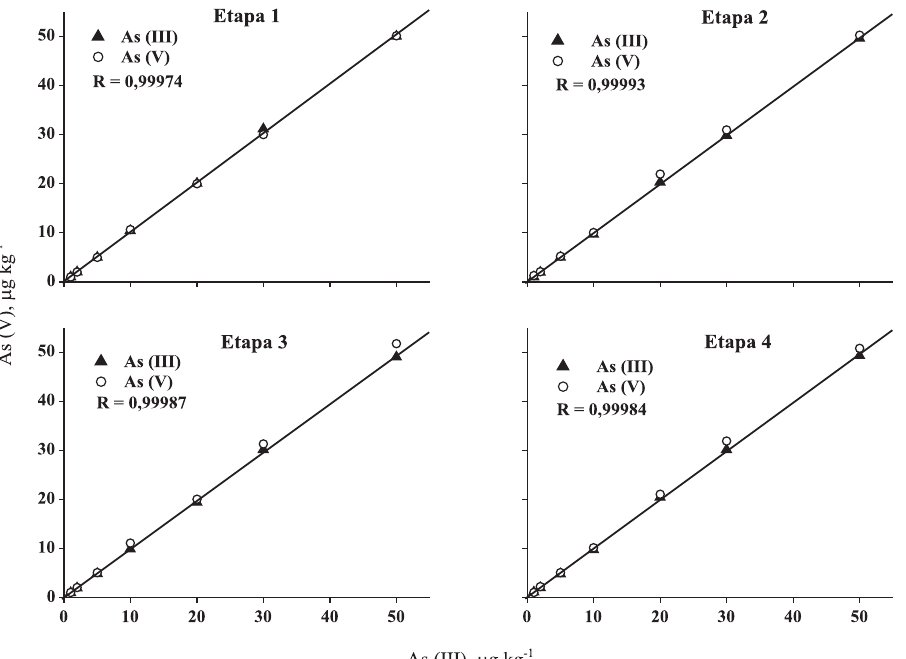
Figura 2. Correlação entre As recuperado a partir de soluções de As(V) tratadas com as condições pré- redutoras selecionadas para cada etapa do método de extração sequencial e soluções-padrão de As(III), nas mesmas